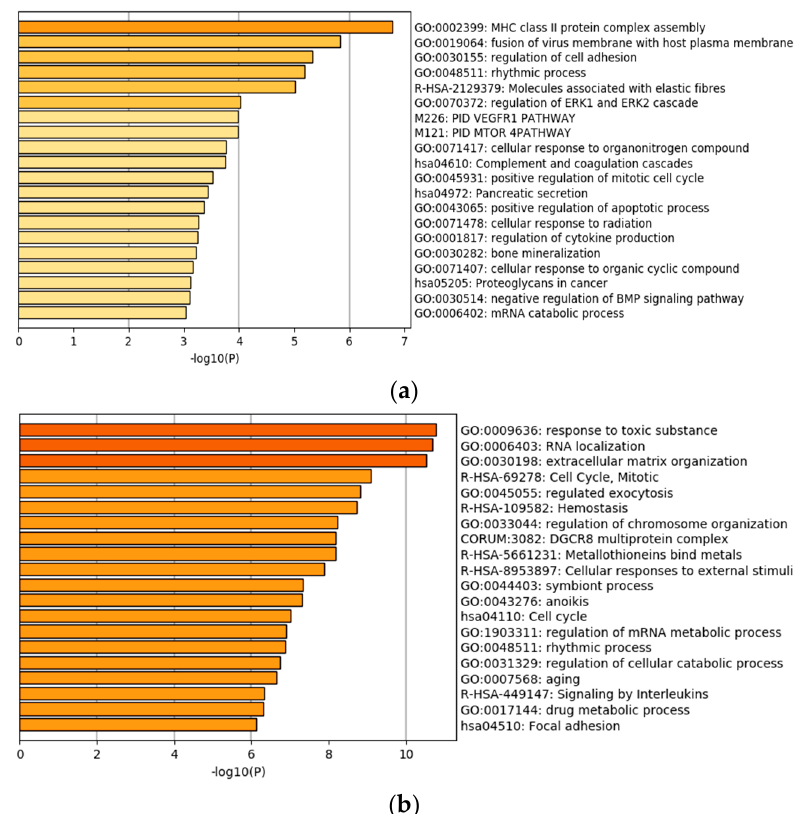
Figure 2. Gene ontology (GO) and pathway enrichment analysis of the identified genes. ( a ) lung adenocarcinoma (LUAD), ( b ) liver hepatocellular carcinoma (LIHC).